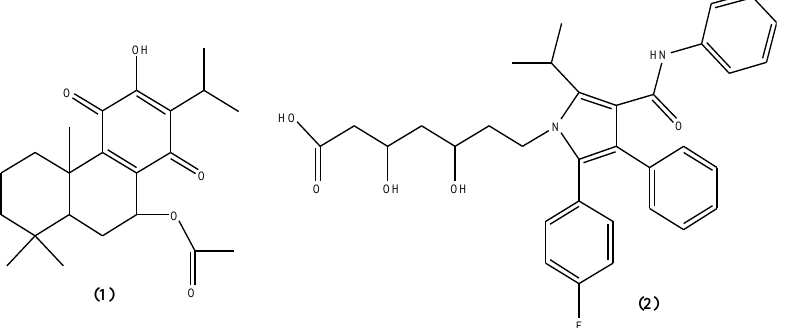
Figure 4. Chemical formulae of the isolated compounds, i.e. , 7-acetoxyhorminone ( 1 ) and atorvastatin ( 2 ) .